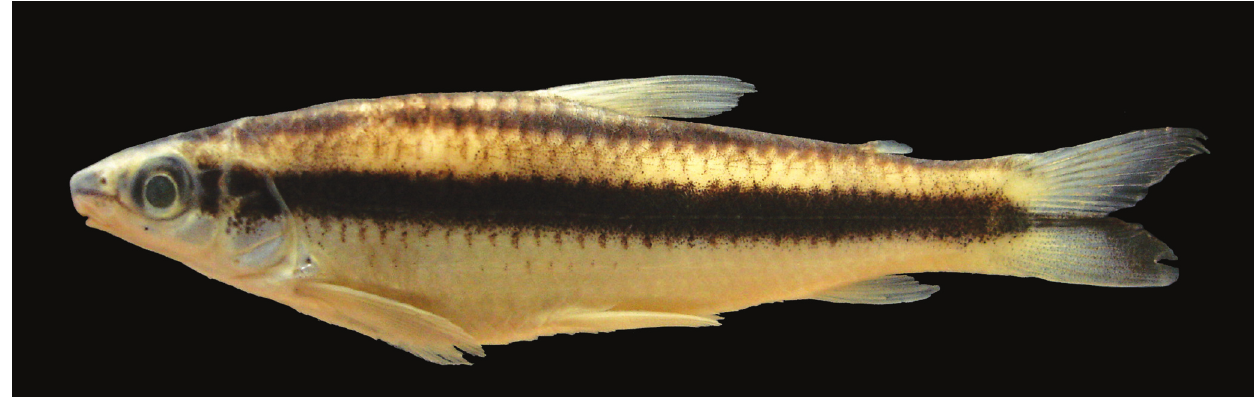
Fig. 9. Parodon pongoensis , ICN 15378, 45.9 mm SL, Colombia, Amazon River Basin, downstream from Puerto